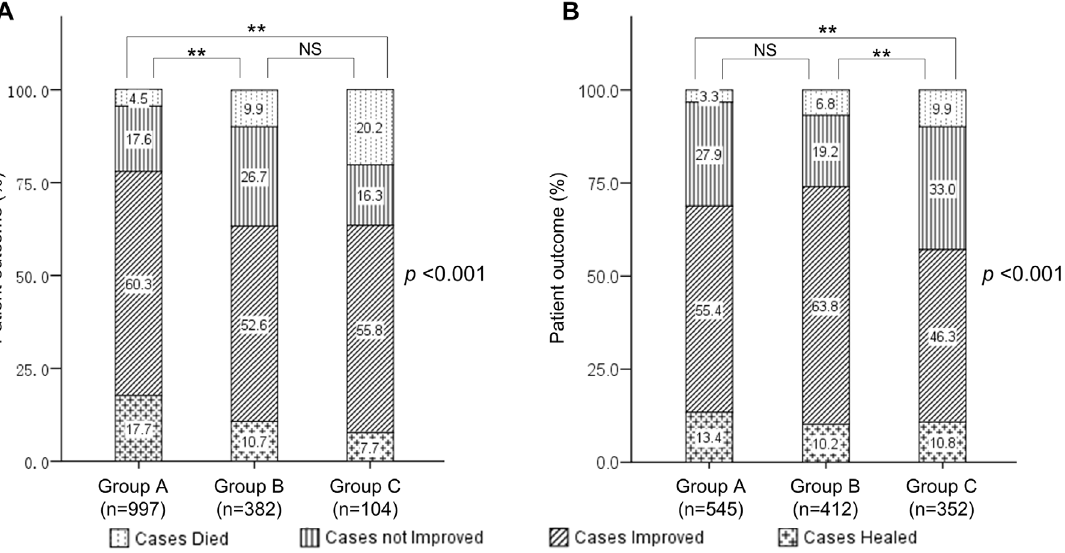
Figure 2. The relationship between the frequency of critical values and patient outcomes. Note: (A) critical values of serum potassium. (B) critical values of platelet count. The patients were divided into 3 groups based on the frequency of the critical values: group A (1 time), group B (2– 3 times), group C ( $ 4 times). Statistics: Kruskal-Wallis nonparametric test, p -values shown. Man-Whitney U tests (**, p , 0.0033. NS, not significant).